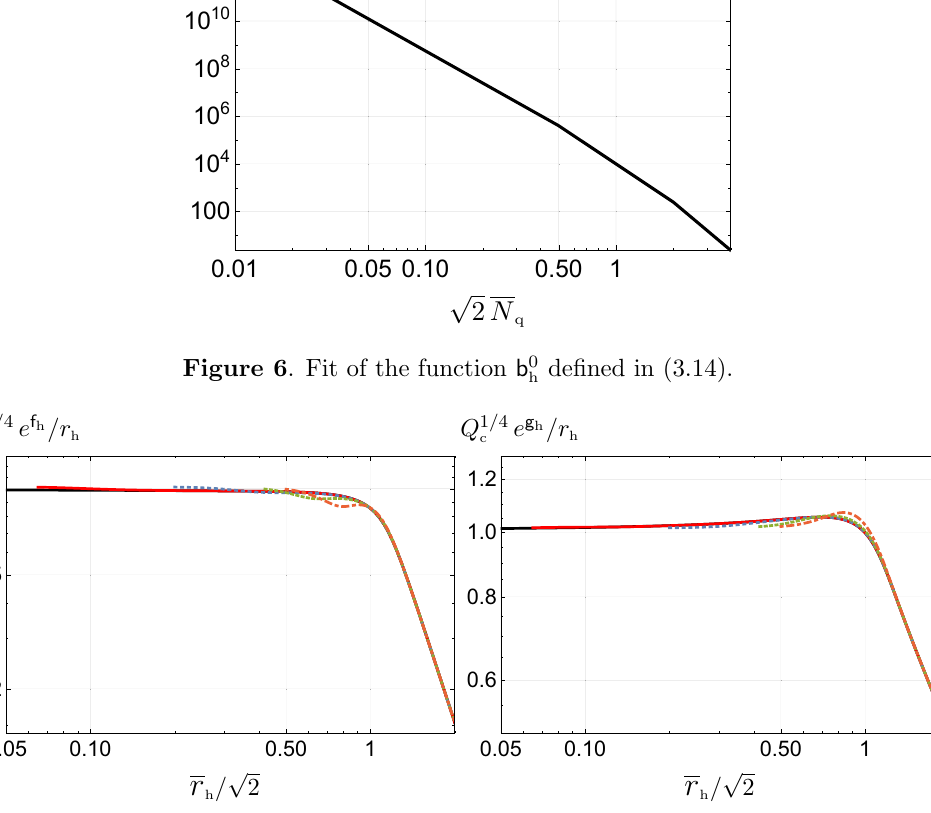
, g for different values of √ 2 N h h